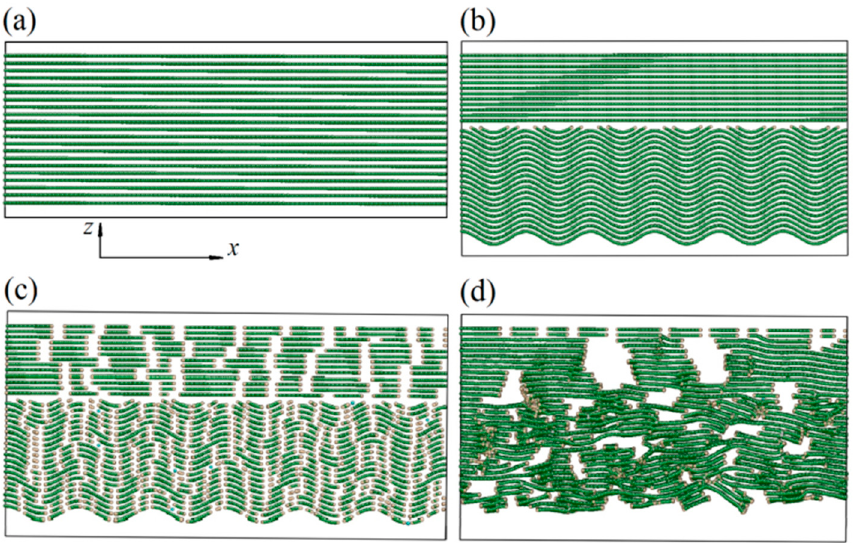
Figure 1. Establishment of the molecular dynamics (MD) model of the C f /PyC interphase. ( a ) initial perfect hexagonal graphite structure; ( b ) deformed using the cosine function; ( c ) after cutting; ( d ) final structure.